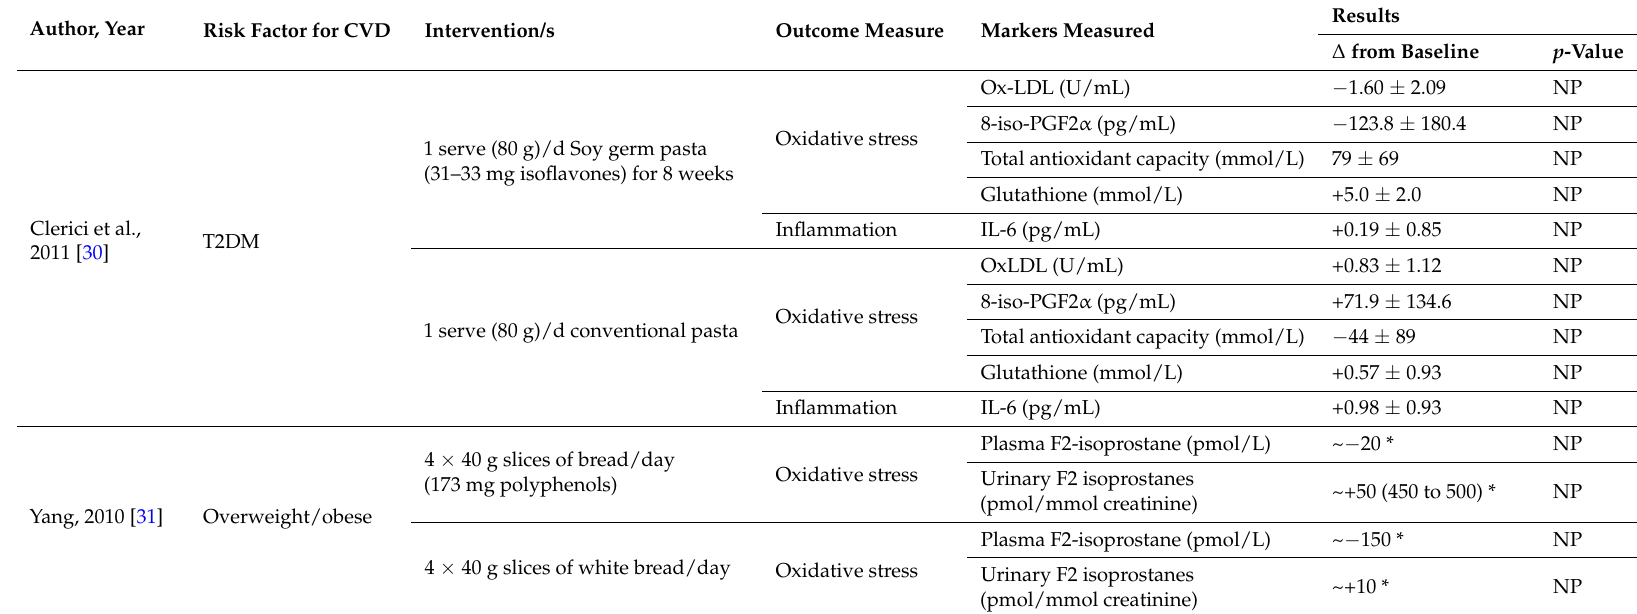
Table 9. Effect of modified grain foods on oxidative stress and inflammation post